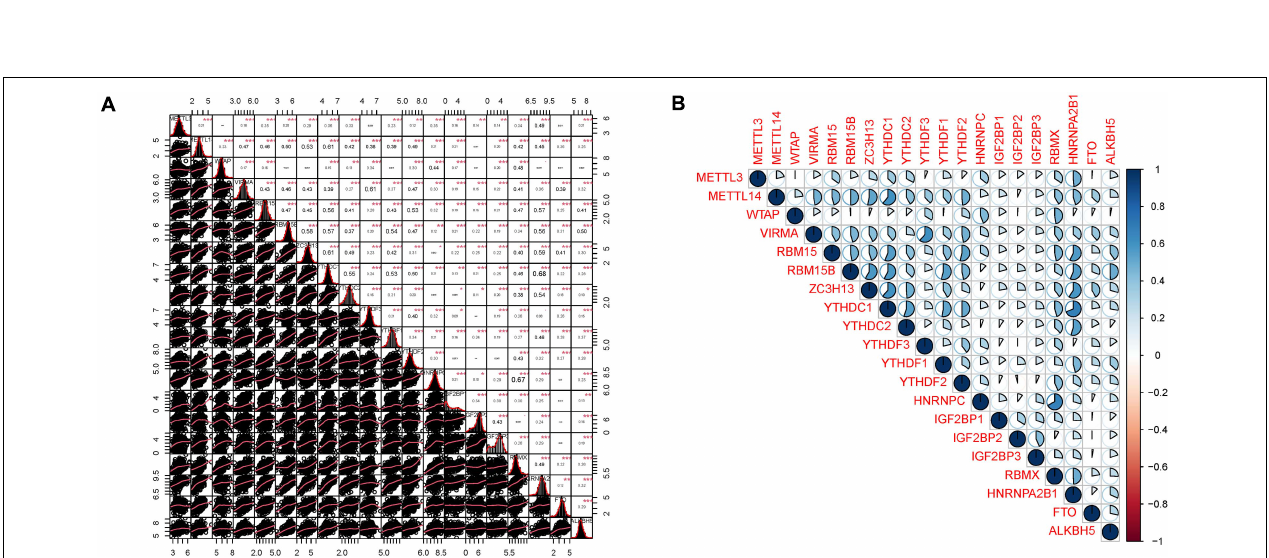
FIGURE 3 | Correlation analysis among m6A related genes. (A) The distributions of each sample and the correlation coefficients were calculated. (B) The correlation coefficients were drawn by pie charts.